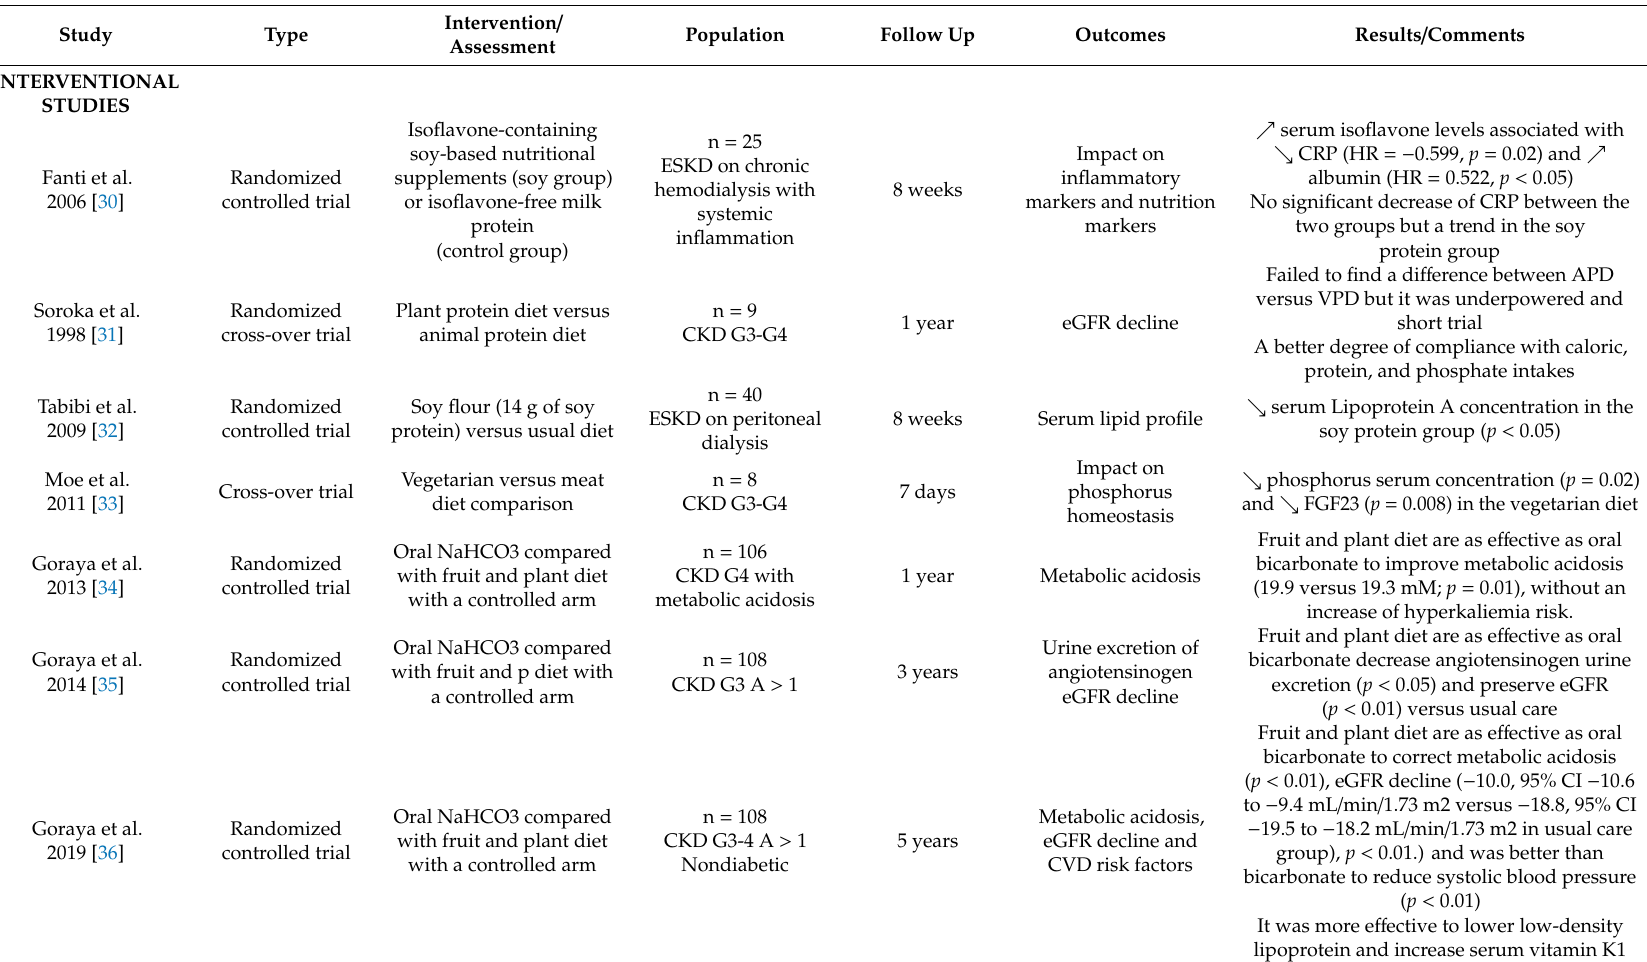
Table 2. Interventional studies analyzing the e ff ect of plant protein or plant-based dietary pattern on CKD